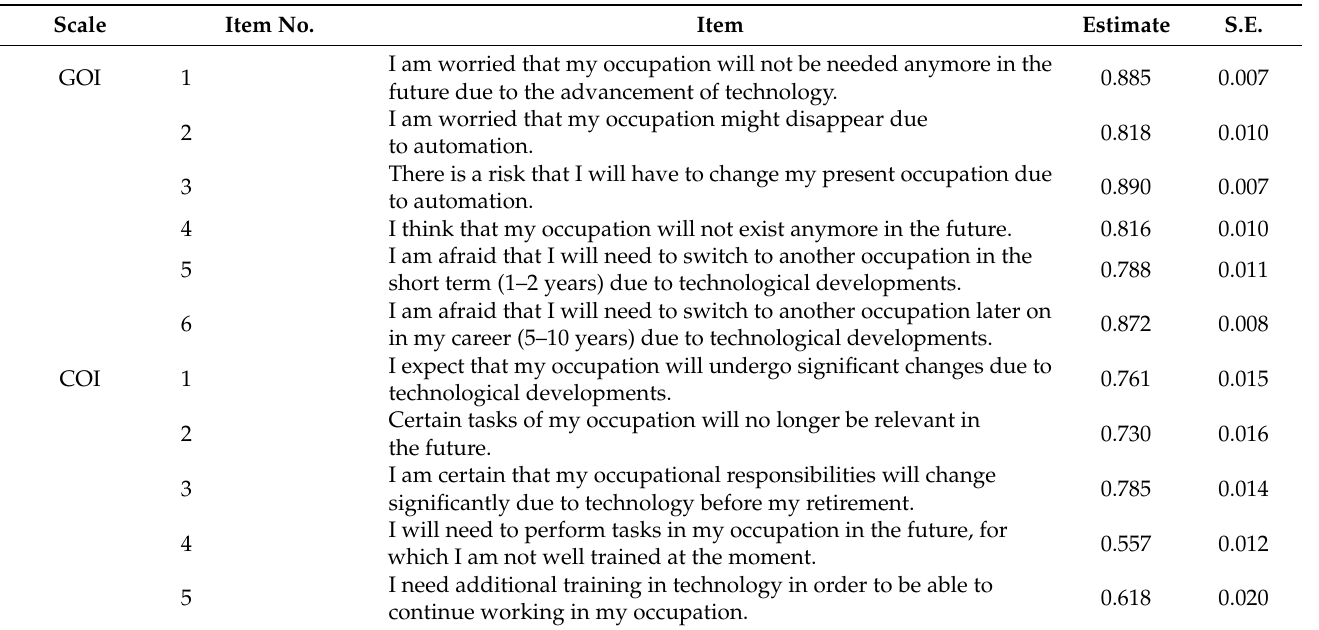
Table 1. Results of the confirmatory factor analysis (CFA) of the final scale: standardized compo- nent